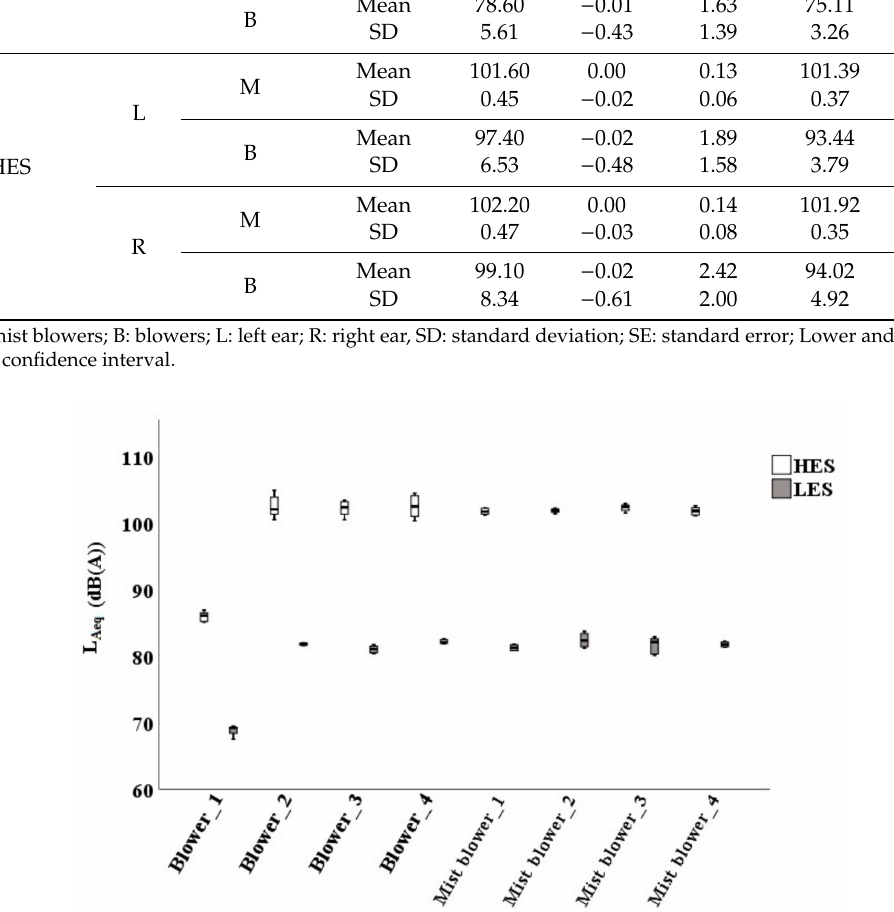
Figure 11. Noise pressure levels at the operators’ ear in all the examined machines at LES (low engine speed) and at HES (high engine